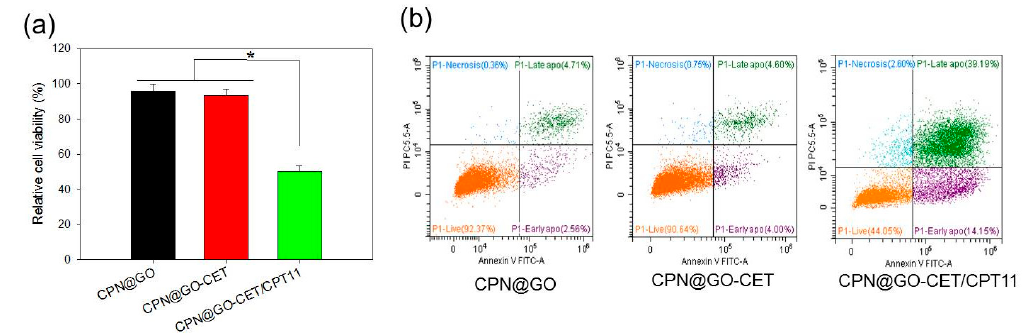
Figure 9. Cell cytotoxicity and cell apoptosis induced by different CPN formulation using U87 cells by 3-(4,5-dimethylthiazol-2-yl)-5-(3-carboxymethoxyphenyl)-2-(4-sulfophenyl)-2H-tetrazolium (MTS) assays ( a ) and flow cytometry ( b ). * p < 0.05.